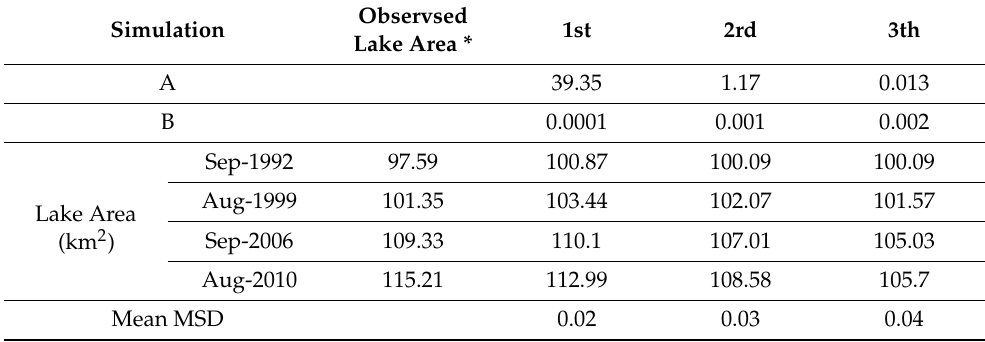
Table 1. Parameters in model